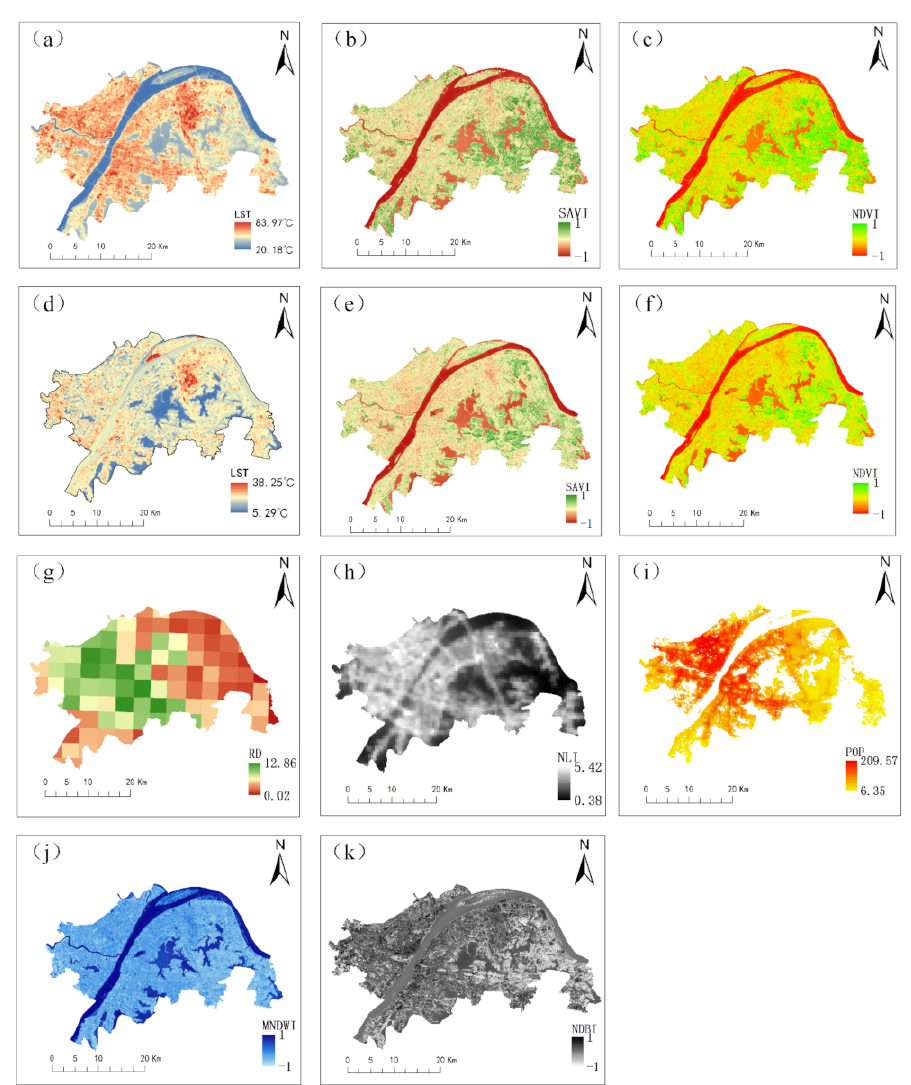
Figure 3. Spatial distribution of LST and potential driving factors in the main urban area of Wuhan. ( a ) LST in summer; ( b ) SAVI in summer; ( c ) NDVI in summer; ( d ) LST in winter; ( e ) SAVI in winter; ( f ) NDVI in winter; ( g ) road density; ( h ) nighttime lighting intensity; ( i ) population